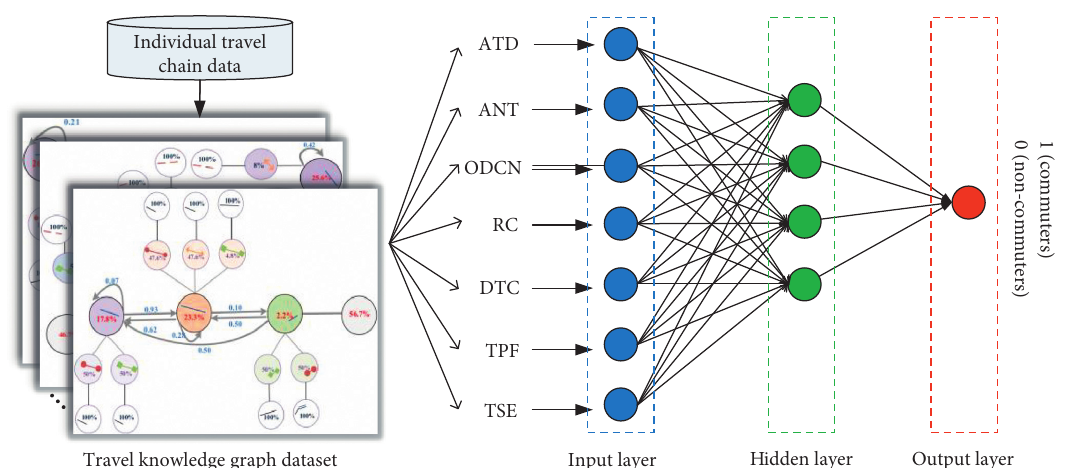
Figure 8: Conceptual structure of PT commuter identification model.